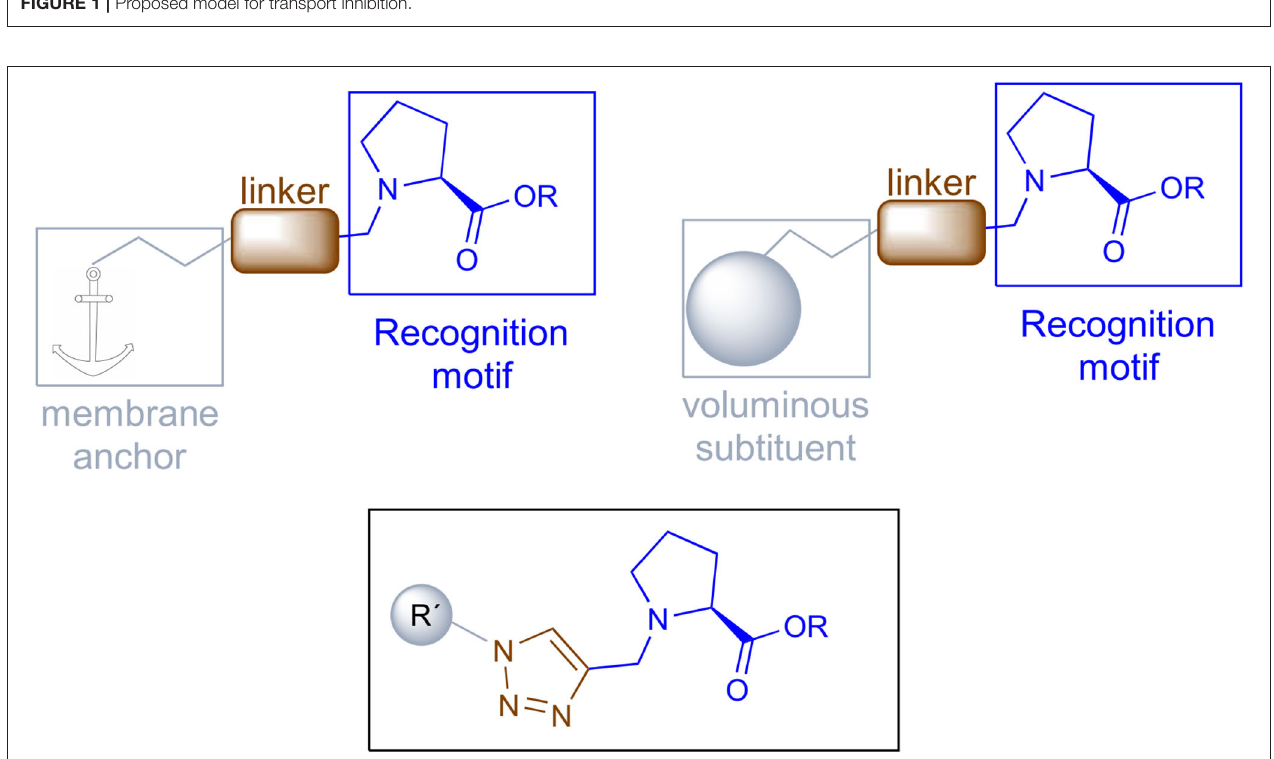
FIGURE 2 | Design of proline transport